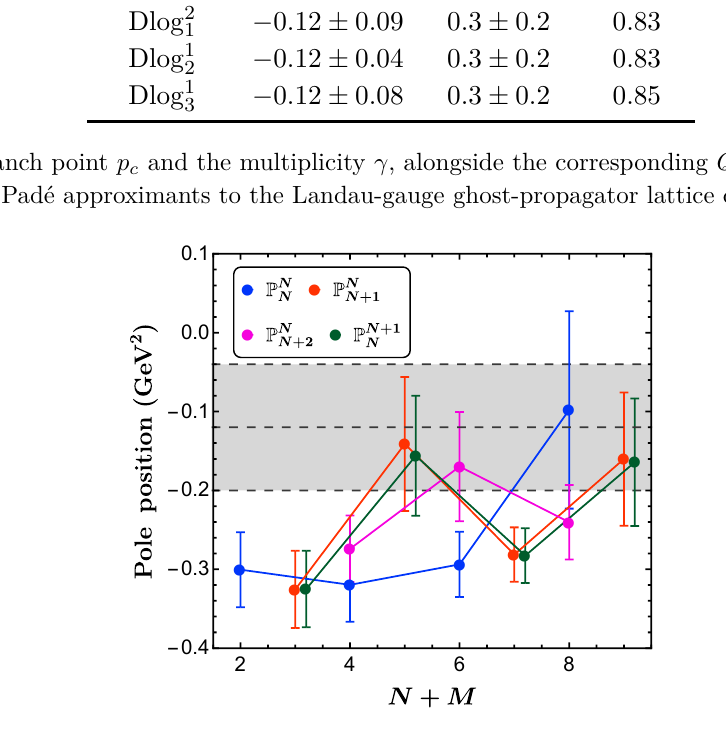
Figure 11 . Comparison of the largest (real and nonzero) pole position from four partial Padés sequences with the branch point position obtained form the D-Log approximants, eq. (5.20), shown as the gray band. At higher-orders the position of the first pole tends to approach the D-Log branch point, indicating that the PPAs are mimicking the cut. We note that the uncertainty on the gray band may be underestimated, since the application of the D-Log Padés requires the calculation of numerical derivatives from the original data